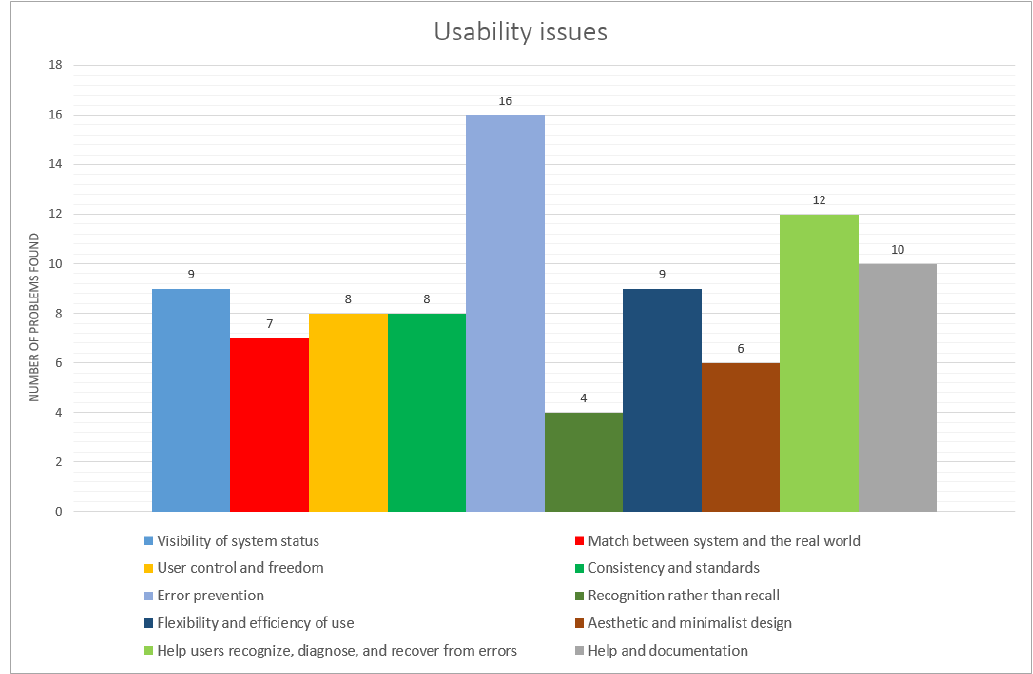
Figure 1. Usability issues encountered by evaluators. Heuristics with most violations were error prevention, help users recognize, diagnose and recover errors and help and